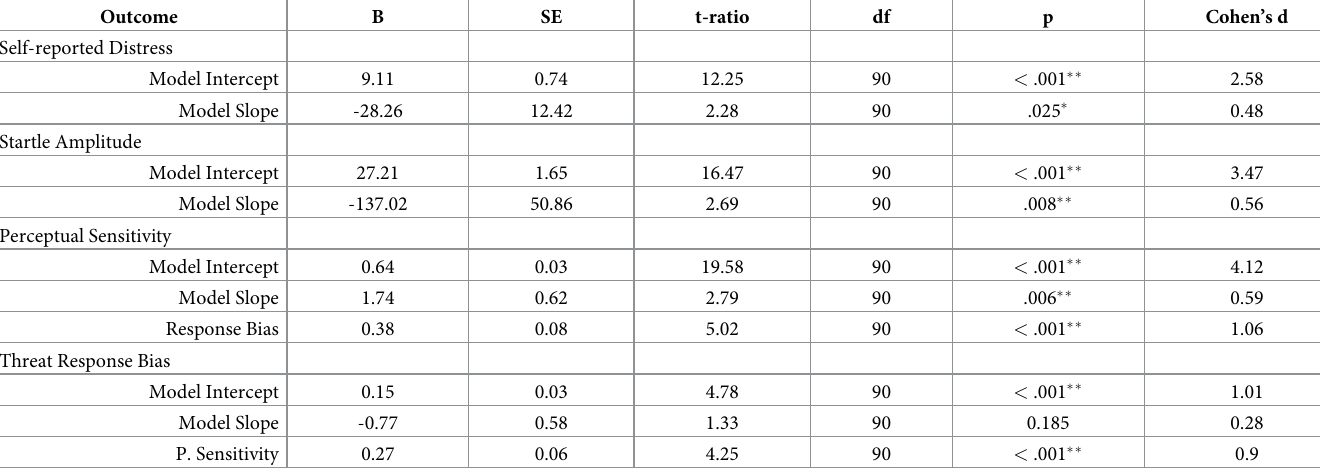
Table 2. Changes in affective tone of recent marathon-related coverage predicts distress, startle reactivity, perceptual sensitivity, and shooting behavior.